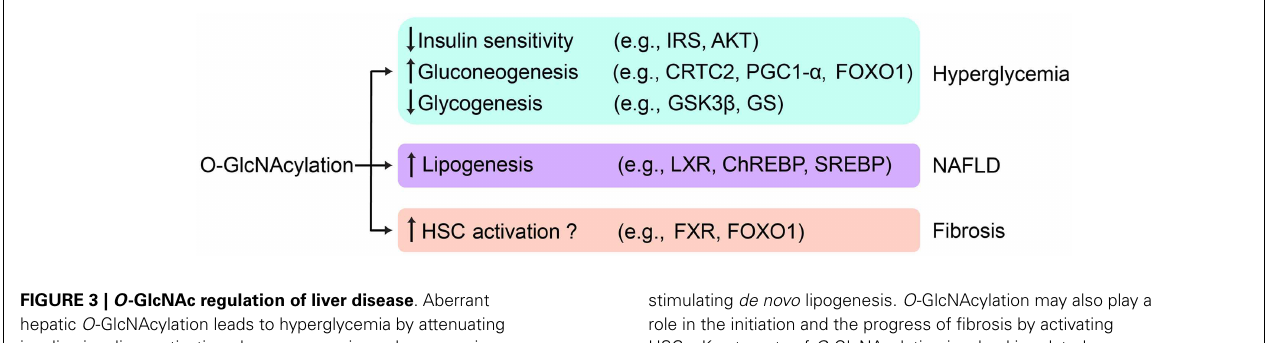
FIGURE 3 | O -GlcNAc regulation of liver disease . Aberrant hepatic O -GlcNAcylation leads to hyperglycemia by attenuating insulin signaling, activating gluconeogenesis, and suppressing glycogen synthesis. O -GlcNAcylation may contribute to NAFLD by